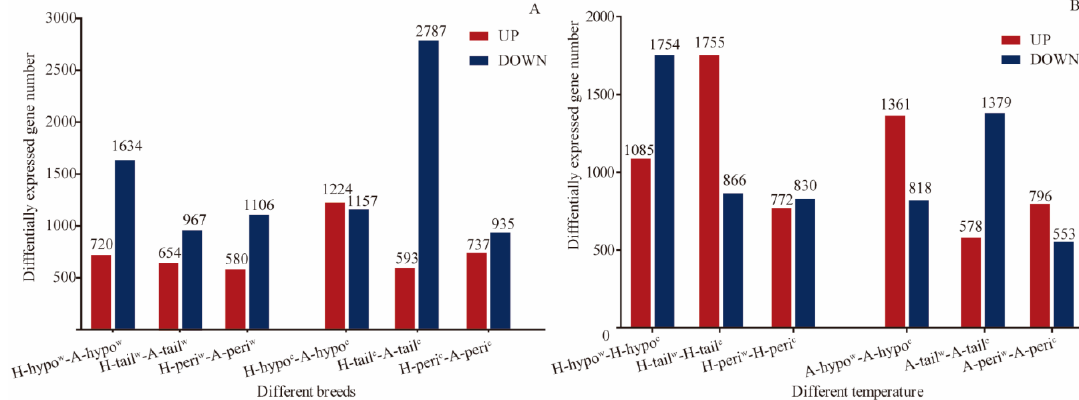
Figure 4. The expression of DEGs in hypothalamus tissue, tail-fat tissue and perirenal fat tissue of cold-exposed Altay and Hu lambs. ( A ) DEGs expressed in Altay and Hu lambs at same air temperature and tissues. ( B ) DEGs expressed at different air temperature ( − 5 °C and 20 °C) within the same breed and tissues. All the compared groups used Hu and thermo-neutral Altay lambs as control groups. H-hypo w -A-hypo w : hypothalamus tissue of the 20 °C Altay lambs compared to the 20 °C Hu lambs. H-tail w -A-tail w : tail-fat tissue of the 20 °C Altay lambs compared to the 20 °C Hu lambs. H-peri w -A-peri w : perirenal fat tissue of the 20 °C Altay lambs compared to the 20 °C Hu lambs. H-hypo c - A-hypo c : hypothalamus tissue of the − 5 °C Altay lambs compared to the − 5 °C Hu lambs; H-tail c -A-tail c : tail-fat tissue of the − 5 °C Altay lambs compared to the − 5 °C Hu lambs. H-peri c -A-peri w : perirenal fat tissue of the − 5 °C Altay lambs compared to the − 5 °C Hu lambs. H-hypo w -H-hypo c : hypothalamus tissue of the − 5 °C Hu lambs compared the 20 °C Hu lambs. H-tail w -H-tail c : tail-fat tissue of the − 5 °C Hu lambs compared the 20 °C Hu lambs. H-peri w -H-peri c : perirenal fat tissue of the − 5 °C Hu lambs compared the 20 °C Hu lambs. A-hypo w -A-hypo c : hypothalamus tissue of the − 5 °C Altay lambs compared the 20 °C Hu lambs. A-tail w -A-tail c : tail-fat tissue of the − 5 °C Altay lambs compared the 20 °C Hu lambs. A-peri w -A-peri c : perirenal fat tissue of the − 5 °C Altay lambs compared the 20 °C Hu lambs.